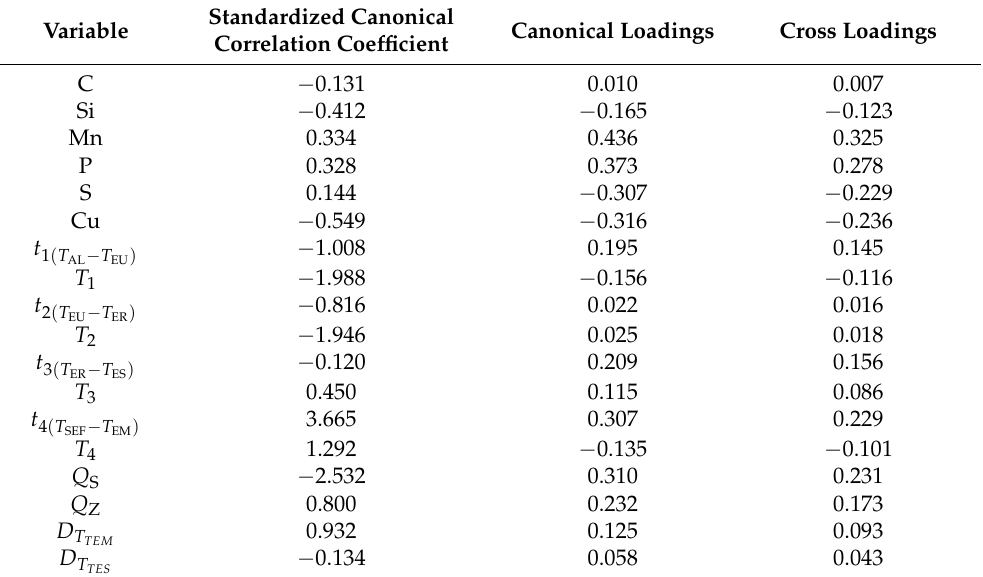
Table 7. Standardized canonical correlation coefficient, canonical loadings and cross loadings of each variable.